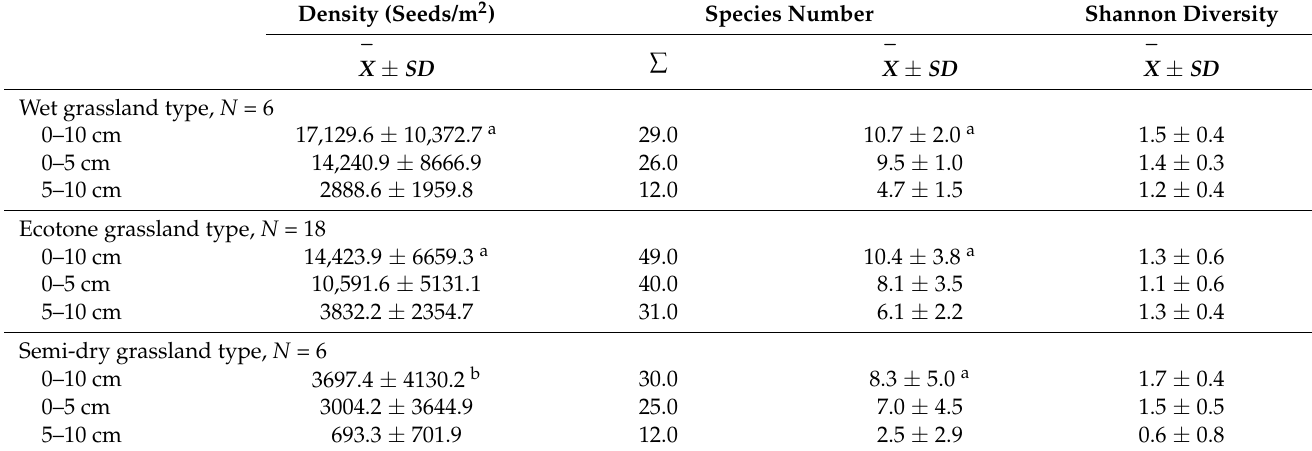
Table 2. Quantitative properties of the soil seed banks in the three grassland types under different water